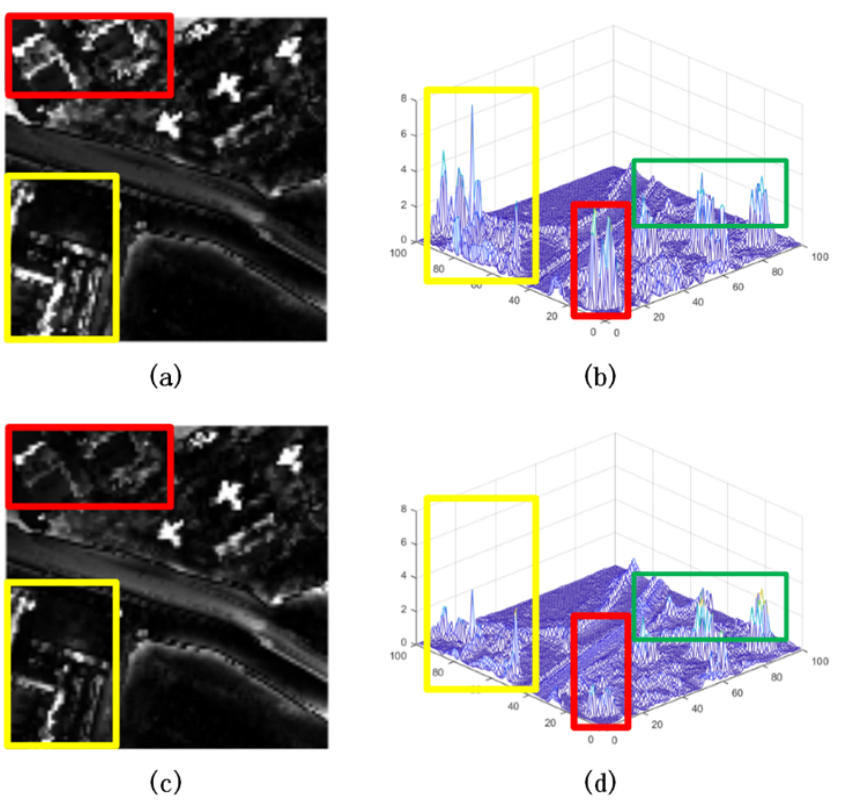
Figure 2. Visual comparison for proposed AD algorithm under complicated background: ( a ) The AD result map of our model with guided filter; ( b ) 3D map corresponding to ( a ); ( c ) the AD result map of our model with weighted guided filter; ( d ) 3D map corresponding to ( c